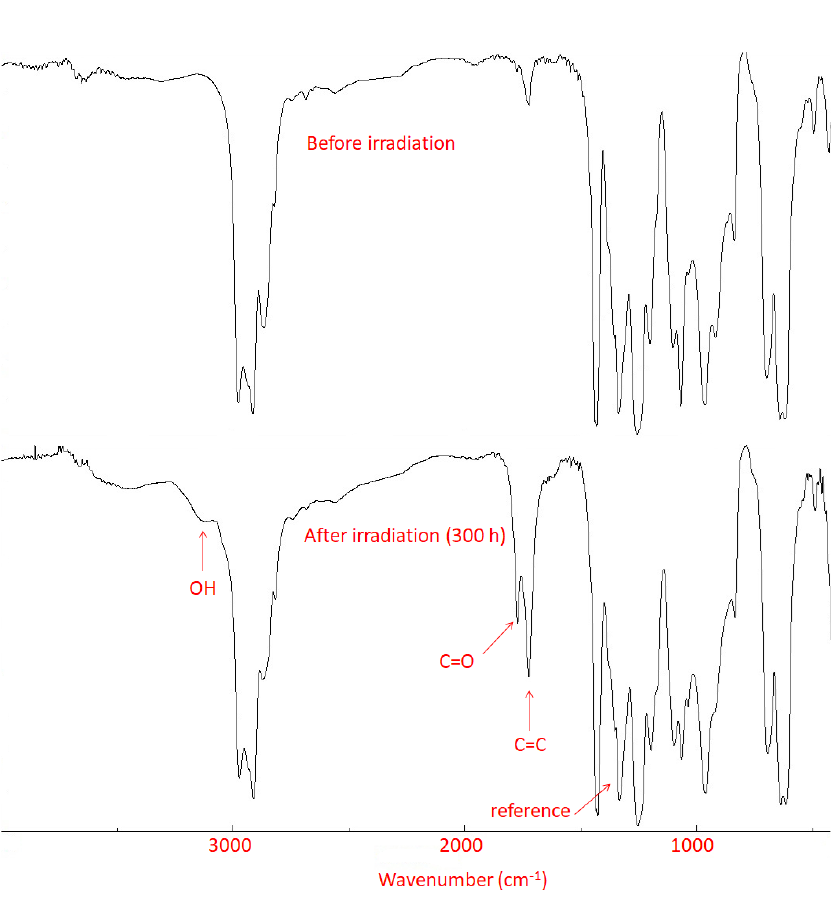
Figure 3. Fourier-transform infrared (FTIR) spectra for PVC (blank) film.